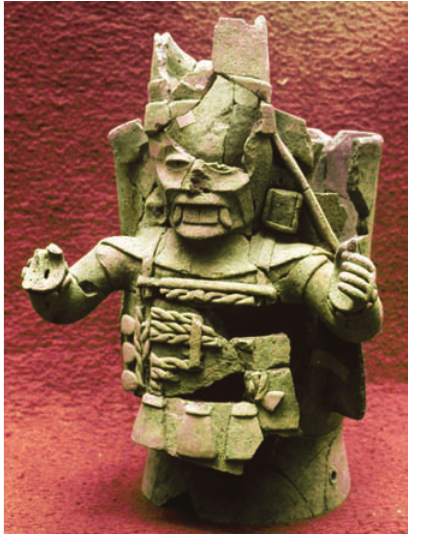
Figure 7 Censers like this one depict human figures in cotton armour. They closely resemble examples from Mayapan, Mexico, but are executed in a distinctly Lamanai